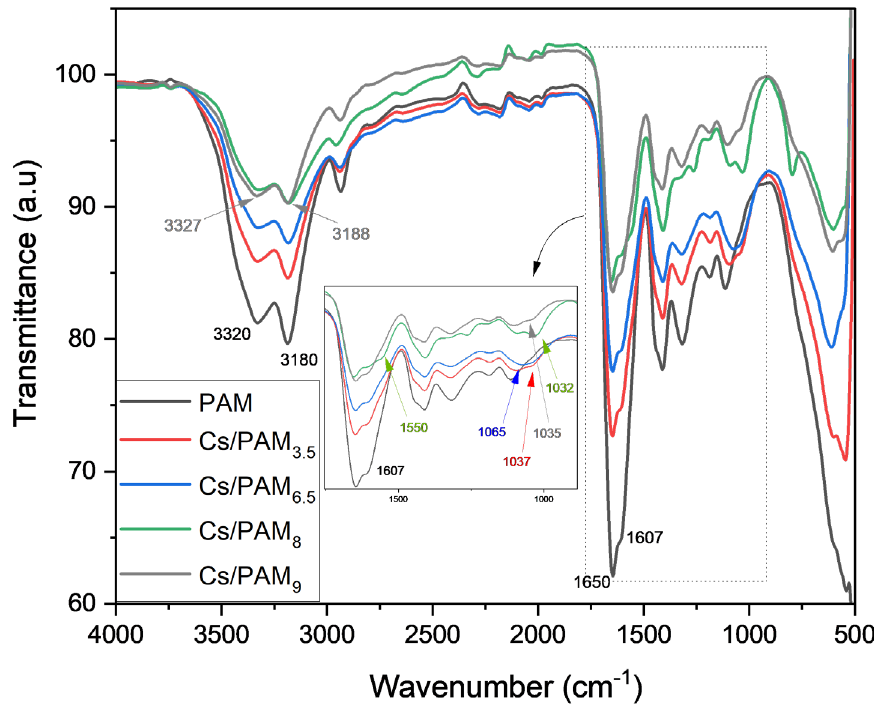
Figure 2. The FTIR spectra of Cs/PAM at various PAM proportions and constant ratio of Cs.